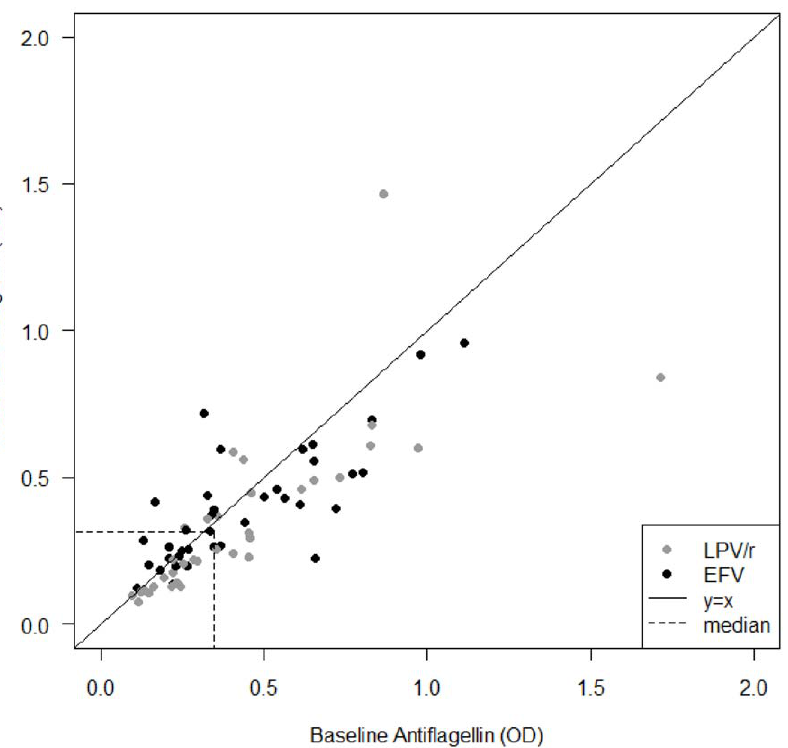
Figure 6. Plasma levels of anti-flagellin antibodies. A significant reduction of anti-flagellin IgG levels was seen after 72 weeks of antiretroviral treatment compared to baseline in the whole cohort. Plasma levels of anti-flagellin IgG decreased significantly in lopinavir/r (LPV/r) treated patients, but not during efavirenz (EFV) therapy. Data are shown as individual values with corresponding baseline anti-flagellin IgG levels at X-axis and week 72 levels at Y-axis, respectively. Individuals treated with lopinavir (LPV/r) are indicated with shaded and efavirenz (EFV) with black circles. Dotted lines refer to median values at the corresponding time-point.